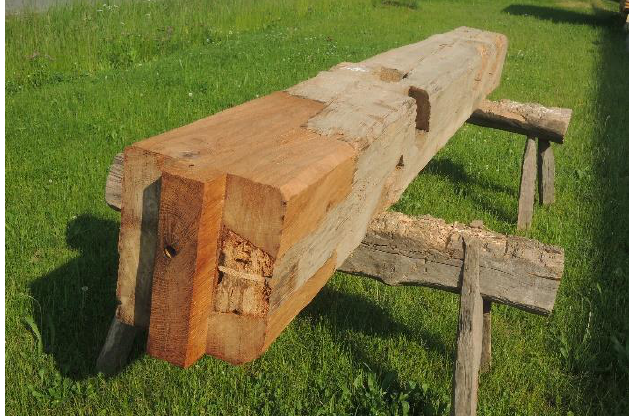
Figure 9. The bottom of the damaged beam (III) after the repair, including the ledge joint secured by a wedge placed in the drying check.